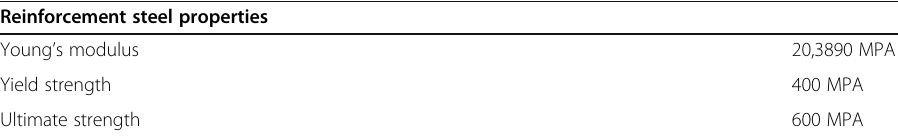
Table 6 Concrete properties Reinforcement steel